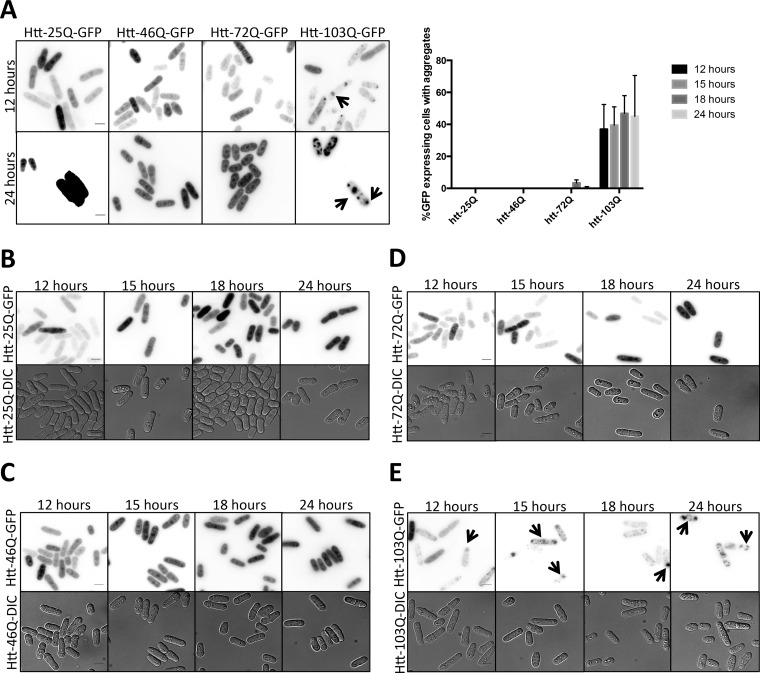
Aggregation of long polyQ-containing Htt proteins expressed in S. pombe. (A) Left, live-cell GFP microscopy of htt-25Q-, htt-46Q-, htt-72Q-, and htt-103Q-integrated S. pombe after 12 h (top) and 24 h (bottom) of induced expression. Images are presented with similar levels of contrast. 25Q is soluble and very highly expressed, leading to saturated intensity. Right, quantification of cells containing aggregated proteins per cells expressing GFP represented as the means of the results of three experiments ± standard errors of the means (SEM). (B to E) Time course of induction of S. pombe expressing (B) Htt-25Q-GFP, (C) Htt-46Q-GFP, (D) Htt-72Q-GFP, and (E) Htt-103Q-GFP. DIC, differential inference contrast. Scale bar, 5 µm.